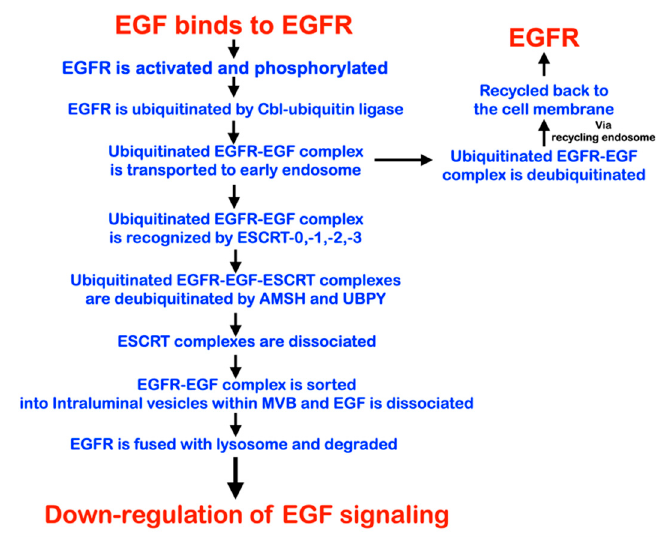
Figure 10. EGFR–Multivesicular Biogenesis–Lysosomal Degradation pathway.